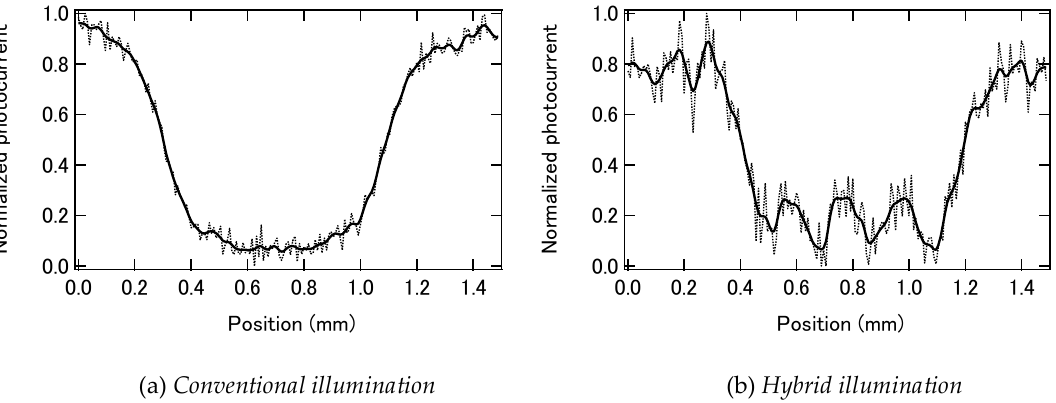
Figure 4. Photocurrent profile across the striped photo-resist pattern with a width of 100 μ